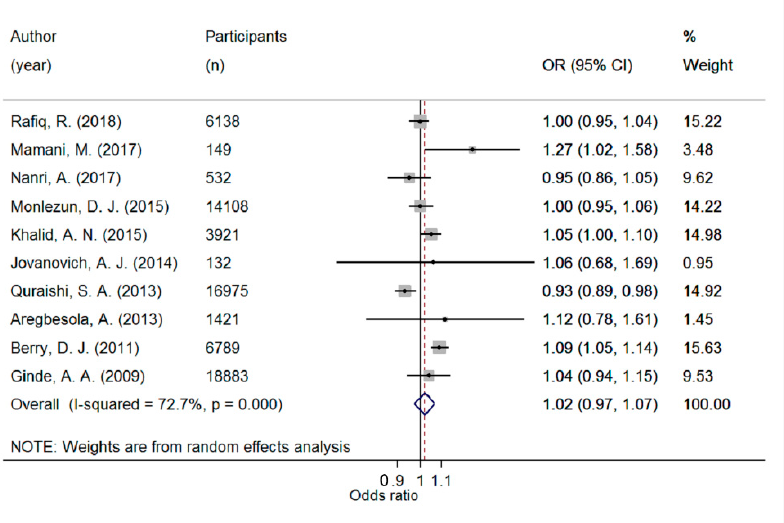
Figure 3. Forest plot displaying odds ratios (OR) and 95% confidence intervals (95% CI) of acute respiratory tract infection risk per 10 nmol/L decrease in 25(OH)D concentration.